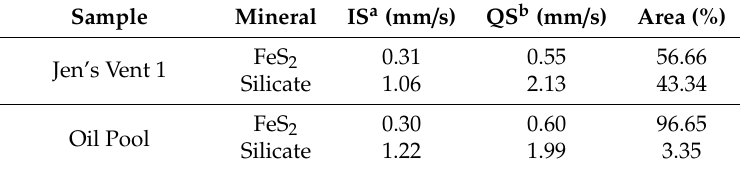
Figure 2. Room temperature 57 Fe Mössbauer spectra of low-spin Fe 2+ in pyrite and high-spin Fe 2+ on the lattice of silicates (Jen’s Vent 1 and Oil Pool). Table 2. Mössbauer spectroscopic parameters of hot spring sediments.